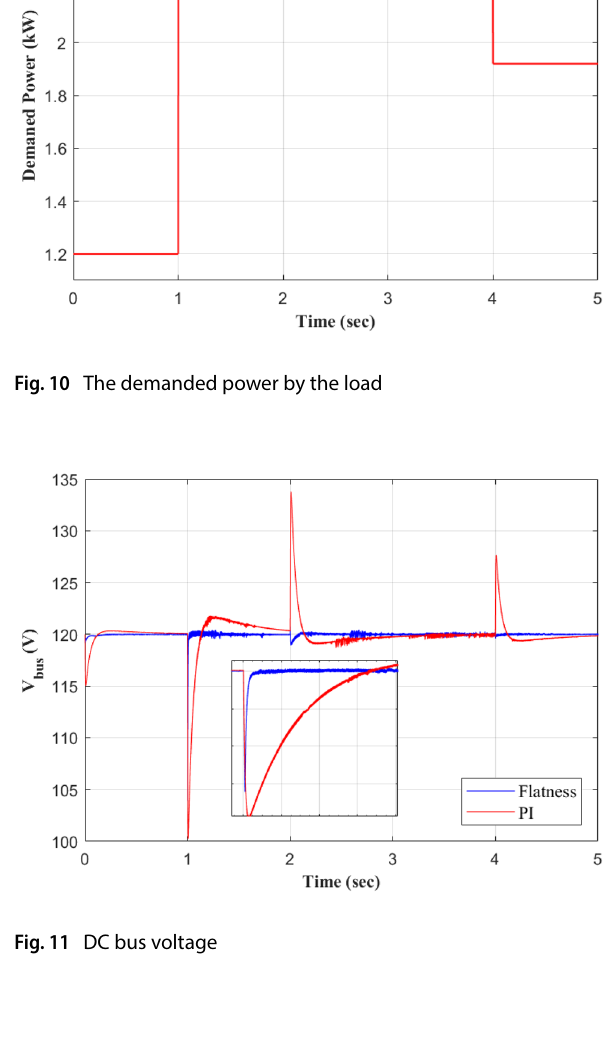
Table 2 System parameters Variable/param- eter